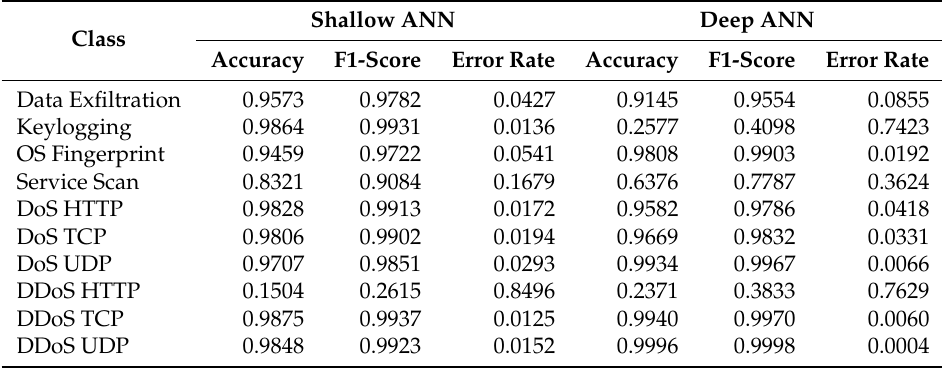
Table 9. Error rate for Type-B binary class models using the Bot-IoT dataset.